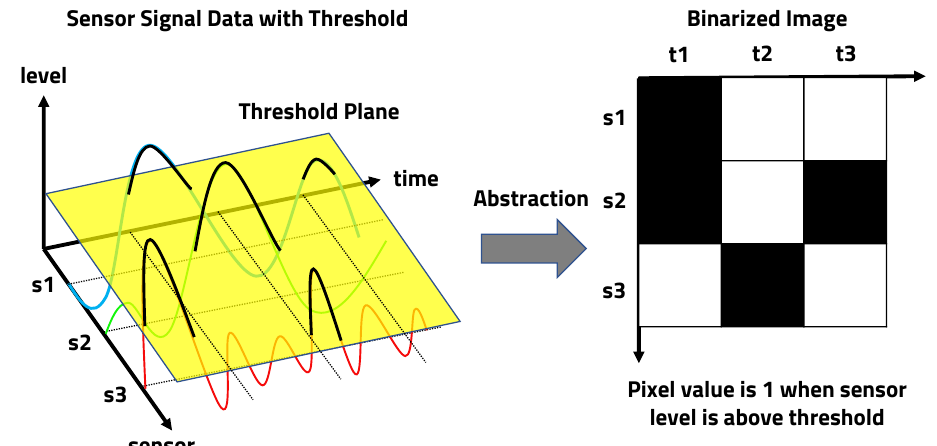
Figure 3. Conversion of sensor signal data to a binarized image by threshold.